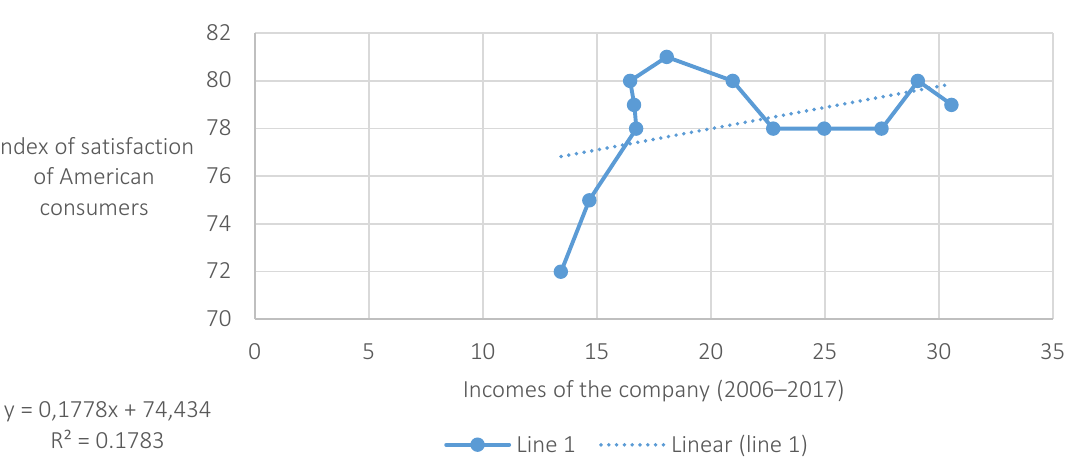
Figure A4. Power line trend for Nike